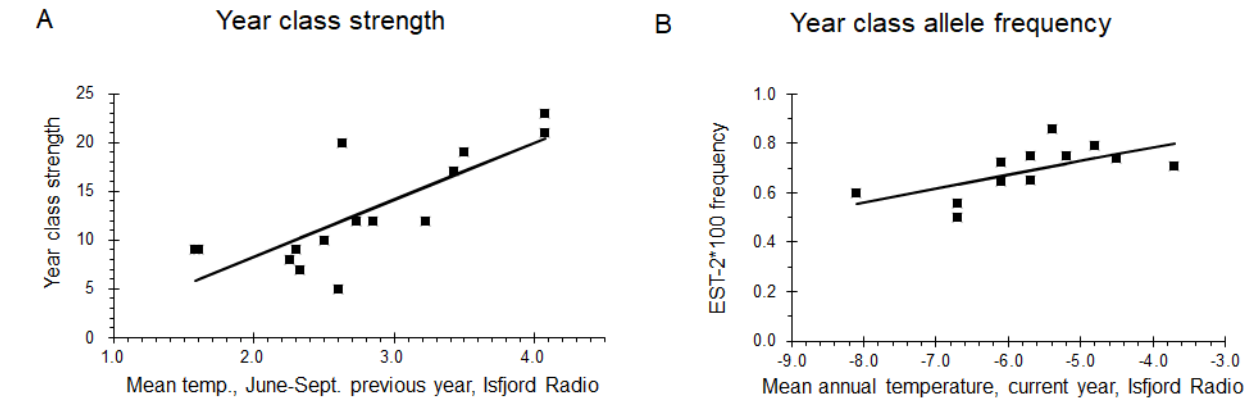
Figure 3. Correlation between air temperature recorded at Isfjord Radio. ( A ) Year-class strength, shown as pooled numbers of all sampled char born in the years 1959–73 (Mean temp., June–September, the year previous to birth), and ( B ) frequencies of the EST-2*100 allele in the year classes 1960–71 (Mean annual temp., current year).